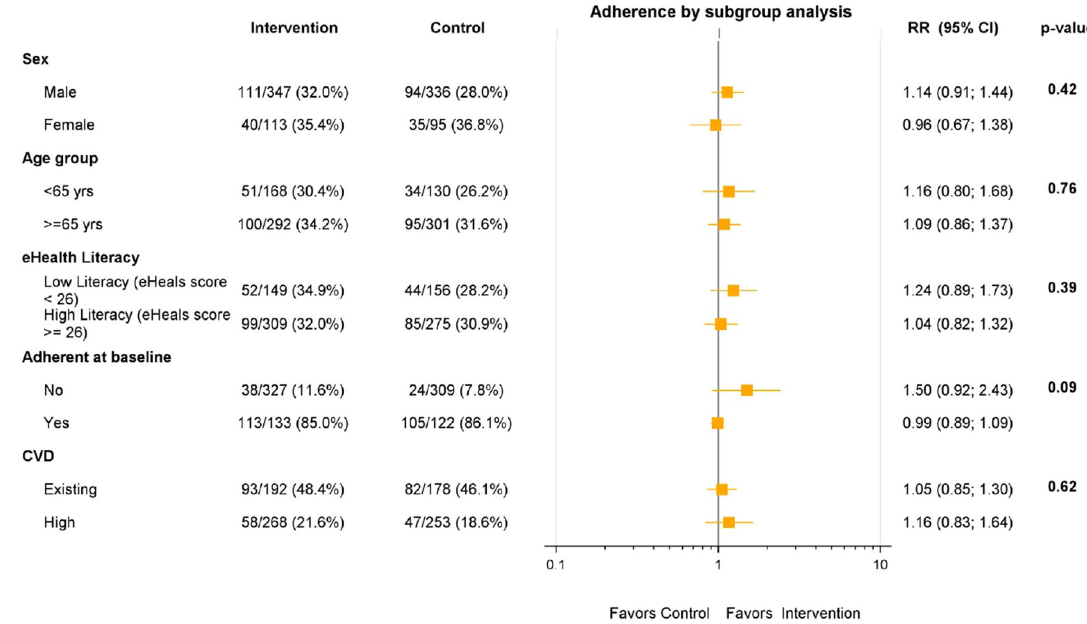
Fig. 4 Sub-group analyses for the primary outcome. yrs years, eHEALS eHealth literacy score, CVD cardiovascular